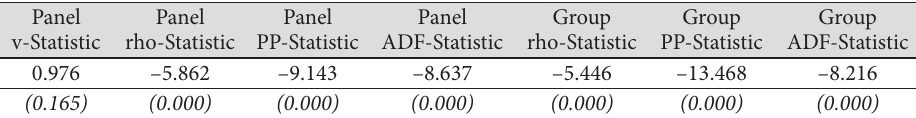
Table 14. Panel co-integration tests (long term variables of OE equation) Panel Panel Panel Panel Group Group Group v-Statistic rho-Statistic PP-Statistic ADF-Statistic rho-Statistic PP-Statistic ADF-Statistic 0.976 (0.165) (0.000) (0.000) (0.000) (0.000) (0.000)